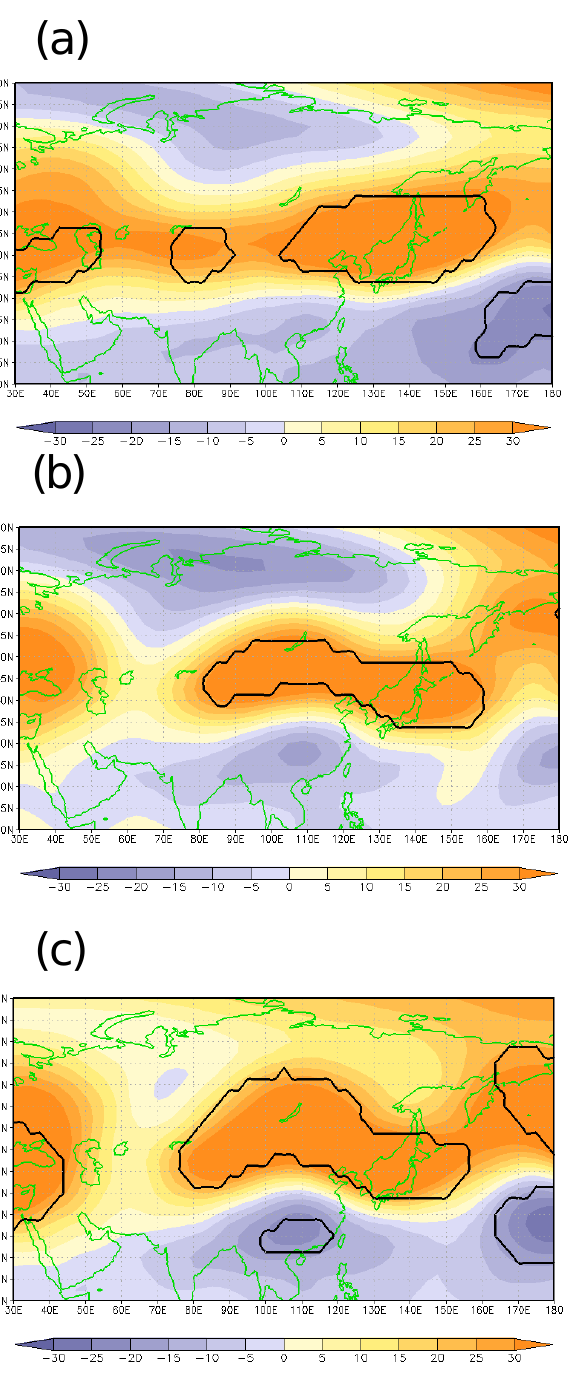
Figure 4. Composite differences in geopotential height (in m) at 150 hPa between hot and cool summer years in ( a ) the Sea of Japan side of Northern Japan (NJJ), ( b ) the Pacific side of Northern Japan (NJP), ( c ) Eastern Japan (EJ), ( d ) Western Japan (WJ), ( e ) the Northeastern part of the Southwest Islands (SIN), and ( f ) the Southwestern part of the Southwest Islands (SIS). The borders of regions that reached a significance of 95% are shown with thick lines.